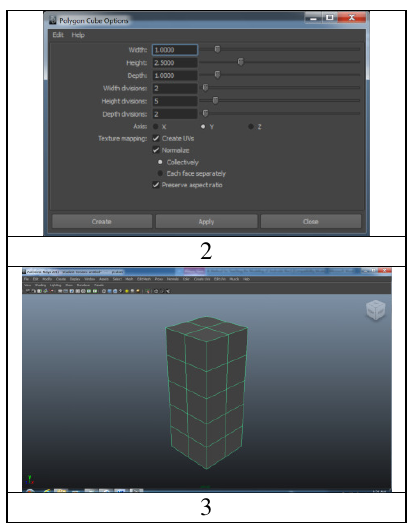
Figure 11. Robot Manikins Created by